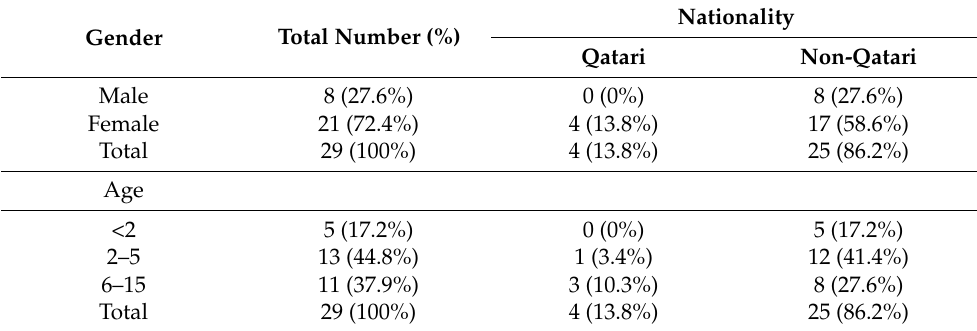
Table 1. Demographic profile of the study population ( n = 29 ).